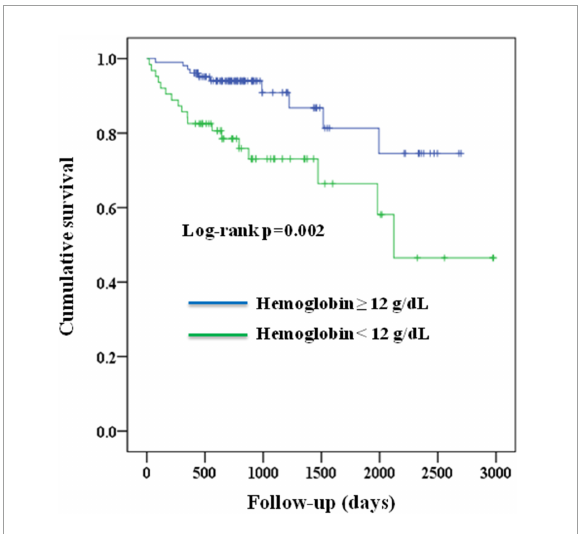
FIGURE1 Kaplan–Meier survival curves of the study population according to their pre-operative hemoglobin levels ( < 12 g/dL vs. ≥ 12 g/dL).